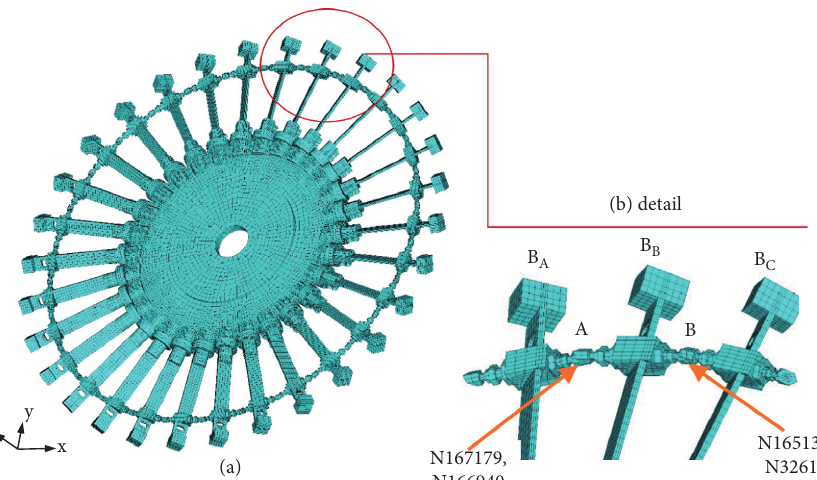
Figure 3: (a) FE mesh of the bladed model with excitation forces FE. (b) Tip detail of three blades with contact pairs A, B and node numbers in the midst of the surfaces.